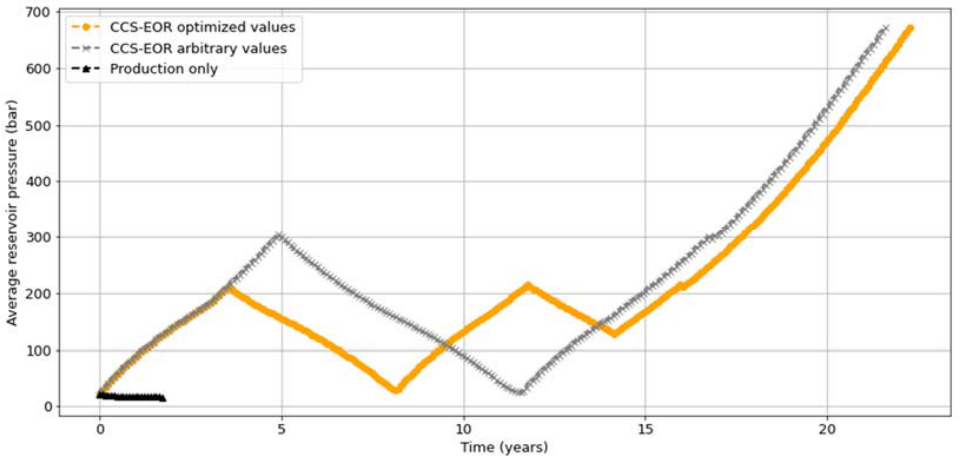
Figure 7. Comparison of the average reservoir pressure.